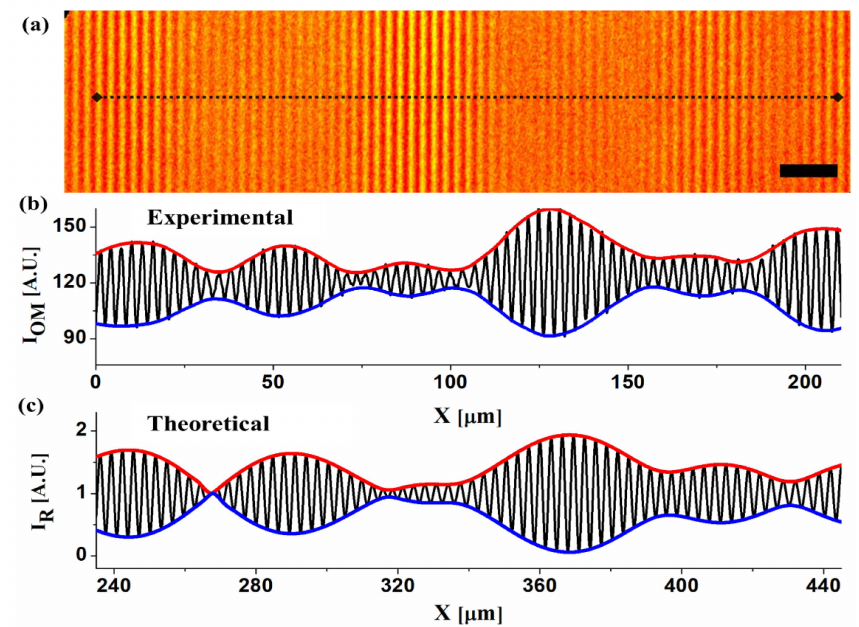
Figure 4. ( a ) Optical microscopy image of the PDR1Ma thin film after the exposure to the multiline interference pattern. The scale bar is 15 µ m. ( b ) Light intensity profile (I OM , gray value) along the black dotted line (200 µ m) in ( a ). ( c ) 200 µ m-portion of the resulting intensity profile evaluated by Equation (1). The red and blue lines showed in ( b , c ) represent respectively the upper and lower envelope of the